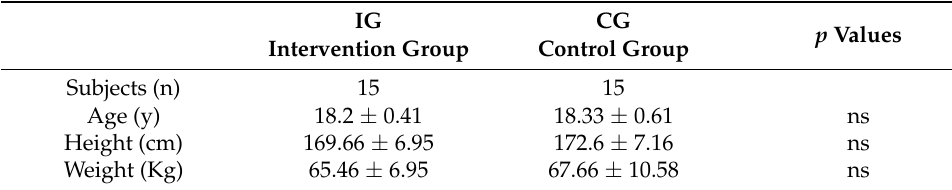
Table 1. Participants’